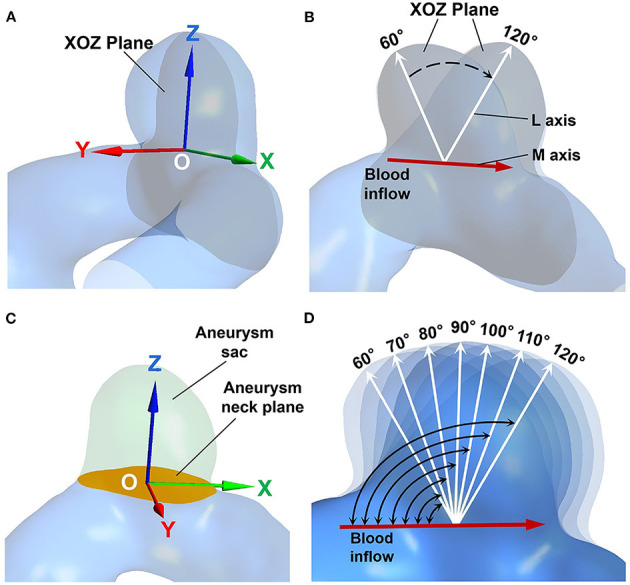
(A) The aneurysm geometry after rigid transformation. The center of the aneurysm neck coincides with the origin (point “O”), the gray plane indicates the XOZ plane. (B) The M axis (red arrow), and the L axis (white arrows) are both on the XOZ plane. (C) The aneurysm sac (marked in green) is separated by the aneurysm neck plane (marked in orange). (D) The IA models exhibiting different inflow angles.